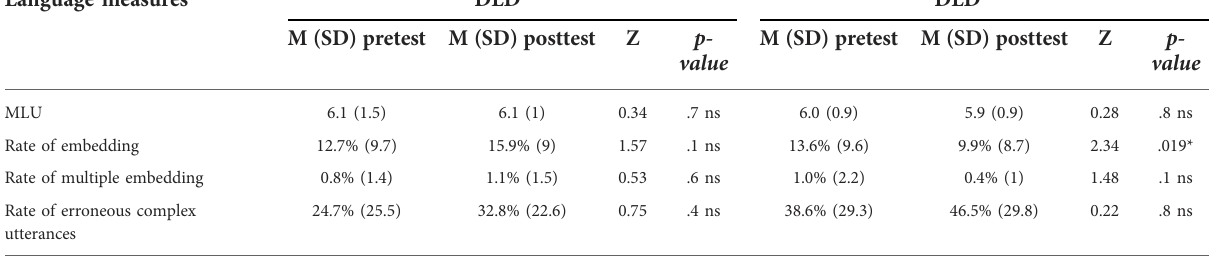
TABLE 5 Pre- and post-training scores in DLD MM and DLD SQULA . Language measures